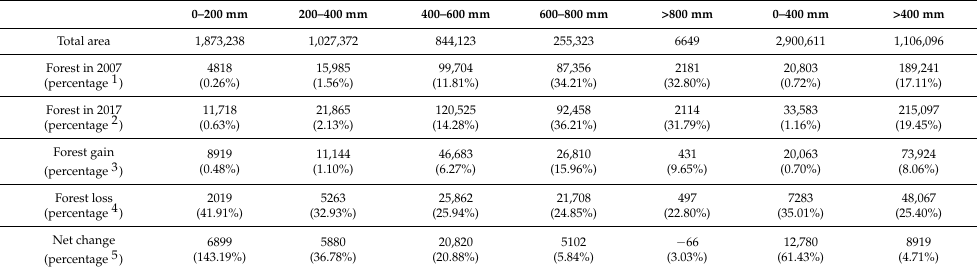
Figure 10. Forest changes (loss and gain) in different precipitation zones from 2007 to 2017. ( a – g ) The ratio of forest loss (2007–2017) in the original forest area (2007) of different precipitation zones. ( h – n ) The ratio of forest gain (2007–2017) in the original non-forest area (2007) of different precipitation zones. Table 4. Forest area (in km 2 ) in 2007 and forest changes in different precipitation zones in northern China from 2007 to 2017. Note that confidence intervals of areal estimates (and derived rates) were not calculated in this table due to the unavailability of sufficiently covered ground truth data in all the strata in each precipitation zone in both 2007 and 2017.